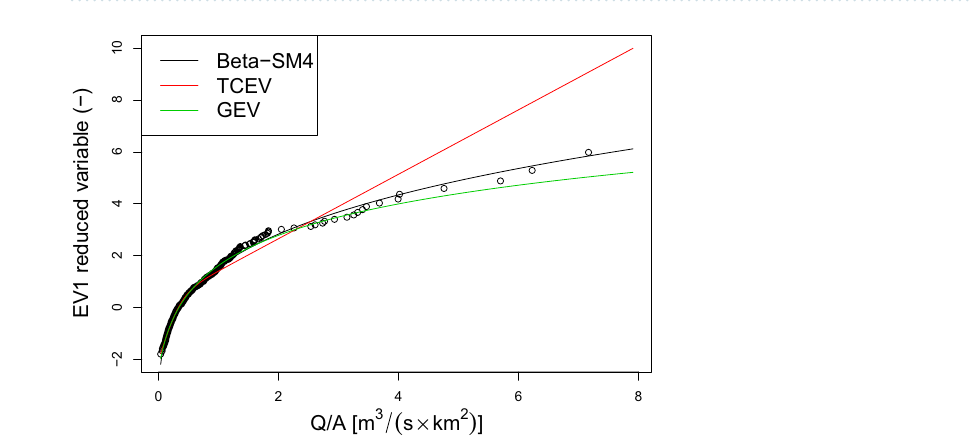
Figure 3. Comparison between Beta-SM4 and TCEV distributions for udometric coefficient data set of